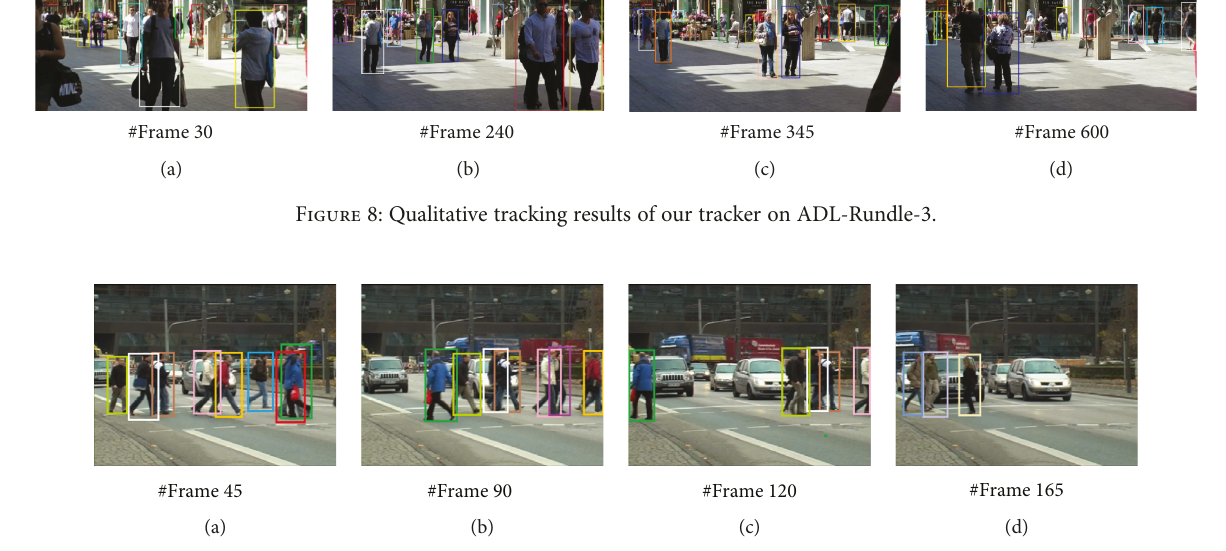
Figure 9: Qualitative tracking results of our tracker on